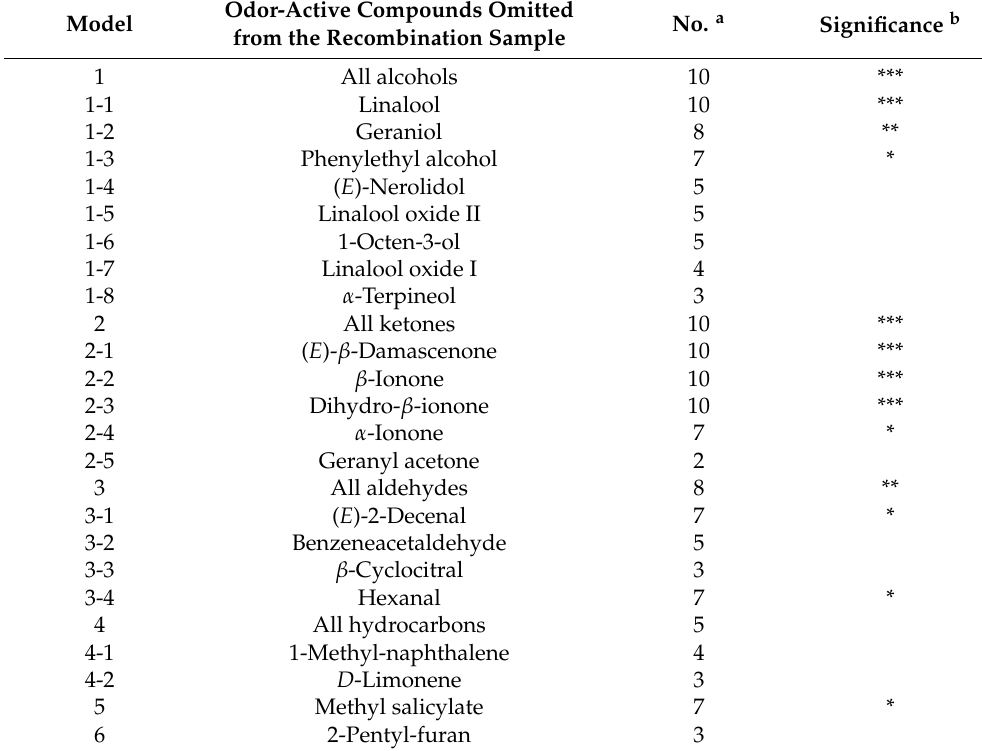
Table 3. The results of the omission test.